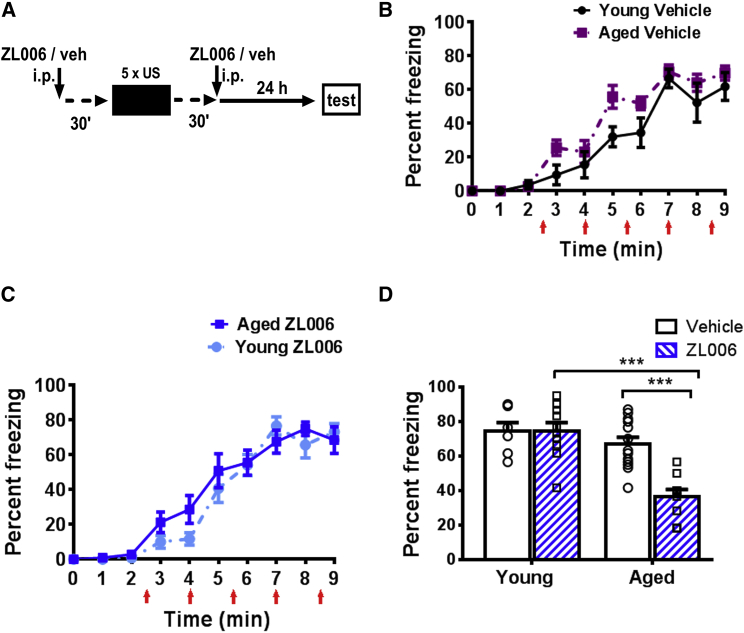
Contextual Fear Memory Formation in Aged but Not Young Mice Is Blocked by ZL006(A) ZL006 (10 mg/kg, i.p.) or vehicle (veh) was administered 30 min before and 30 min after CFC, and contextual fear memory was assessed 24 h after CFC.(B) No effect on acquisition of contextual fear memory after vehicle injection in young and aged mice. (C) No effect on acquisiton by ZL006 treatment in young and aged mice (nYveh = 7, nYZL006 = 10; effect of treatment, F(1,120) = 1.2, p = 0.30; effect of training, F(8,120) = 75.0, p < 0.001; interaction treatment x training, F(8,120) = 1.6, p = 0.15) and aged mice (nAveh = 13, nAZL006 = 9; effect of treatment, F(1,160) = 0.029, p = 0.87; effect of training, F(8,160) = 86.0, p < 0.001; interaction treatment x training, F(8,160) = 0.71, p = 0.68).(D) Contextual fear memory 24 h after conditioning was impaired in ZL006-treated aged but not young mice (effect of age, F(1,35) = 24.6, p < 0.001; effect of treatment, F(1,35) = 11.1, p < 0.01; interaction age x treatment, F(1,35) = 10.9, p < 0.01; Tukey’s post hoc tests: Yveh versus YZL006, p = 0.99; Aveh versus AZL006, p < 0.001; YZL006 versus AZL006, p < 0.001).Mean ± SEM, ∗∗∗p < 0.001. Individual data plots representing each animal within the group overlay the bar graphs. See also Figures S5 and S6.